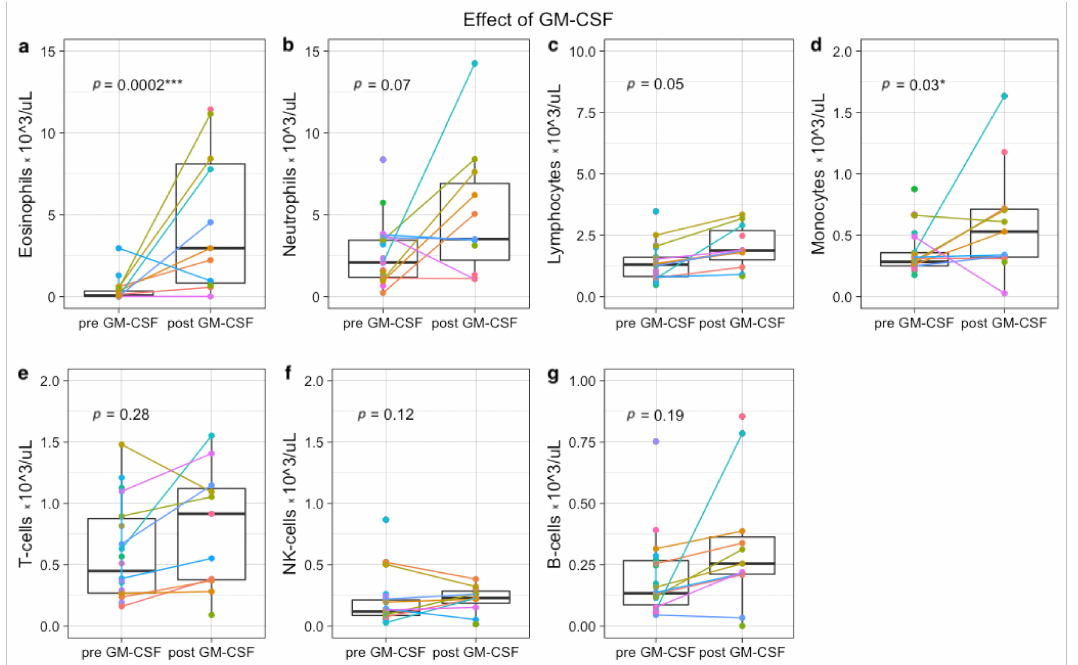
Figure 3. Immune profiles before and after GM-CSF-containing immunotherapy cycle. Each colored dot indicates absolute counts from one patient ( × 10 3 cells/uL). From 5 patients, samples were paired before GM-CSF (day 1 IT cycle 1, 3 or 5) and after GM-CSF (day 15 IT cycle 1, 3 or 5). In total, 9 paired samples are depicted (colored lines), because two patients were monitored during all 3 GM-CSF cycles. Twelve single measurements from 12 other patients were included, resulting in a total of 17 patients (11 in study, 6 left over material during IT). Absolute eosinophil ( a ), neutrophil ( b ), lymphocyte ( c ), monocyte ( d ), T-cell ( e ), NK-cell ( f ), and B-cell numbers ( g ) are shown. * p < 0.05, *** p <